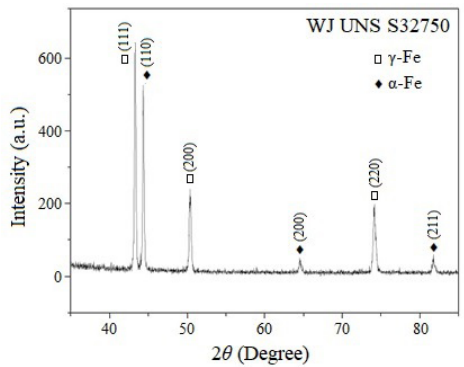
Figure 3. XRD pattern of welded joint.